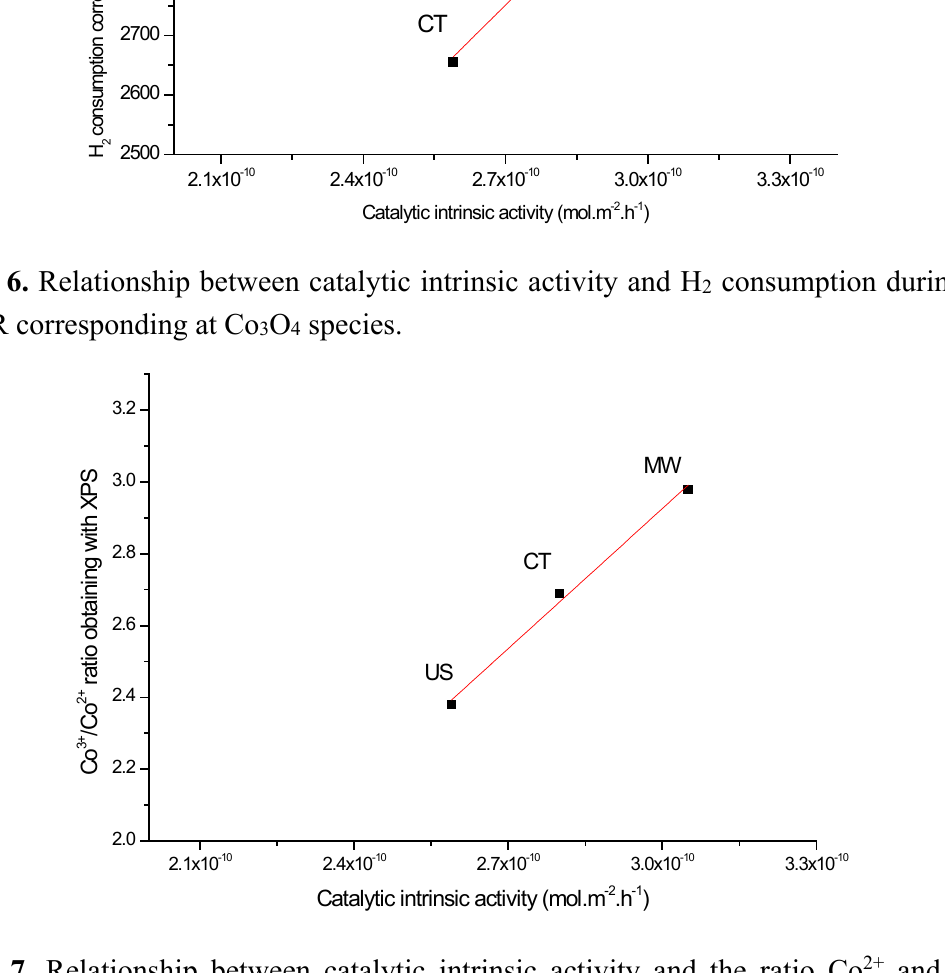
Figure 7. Relationship between catalytic intrinsic activity and the ratio Co 2+ and Co 3+ species calculated with XPS